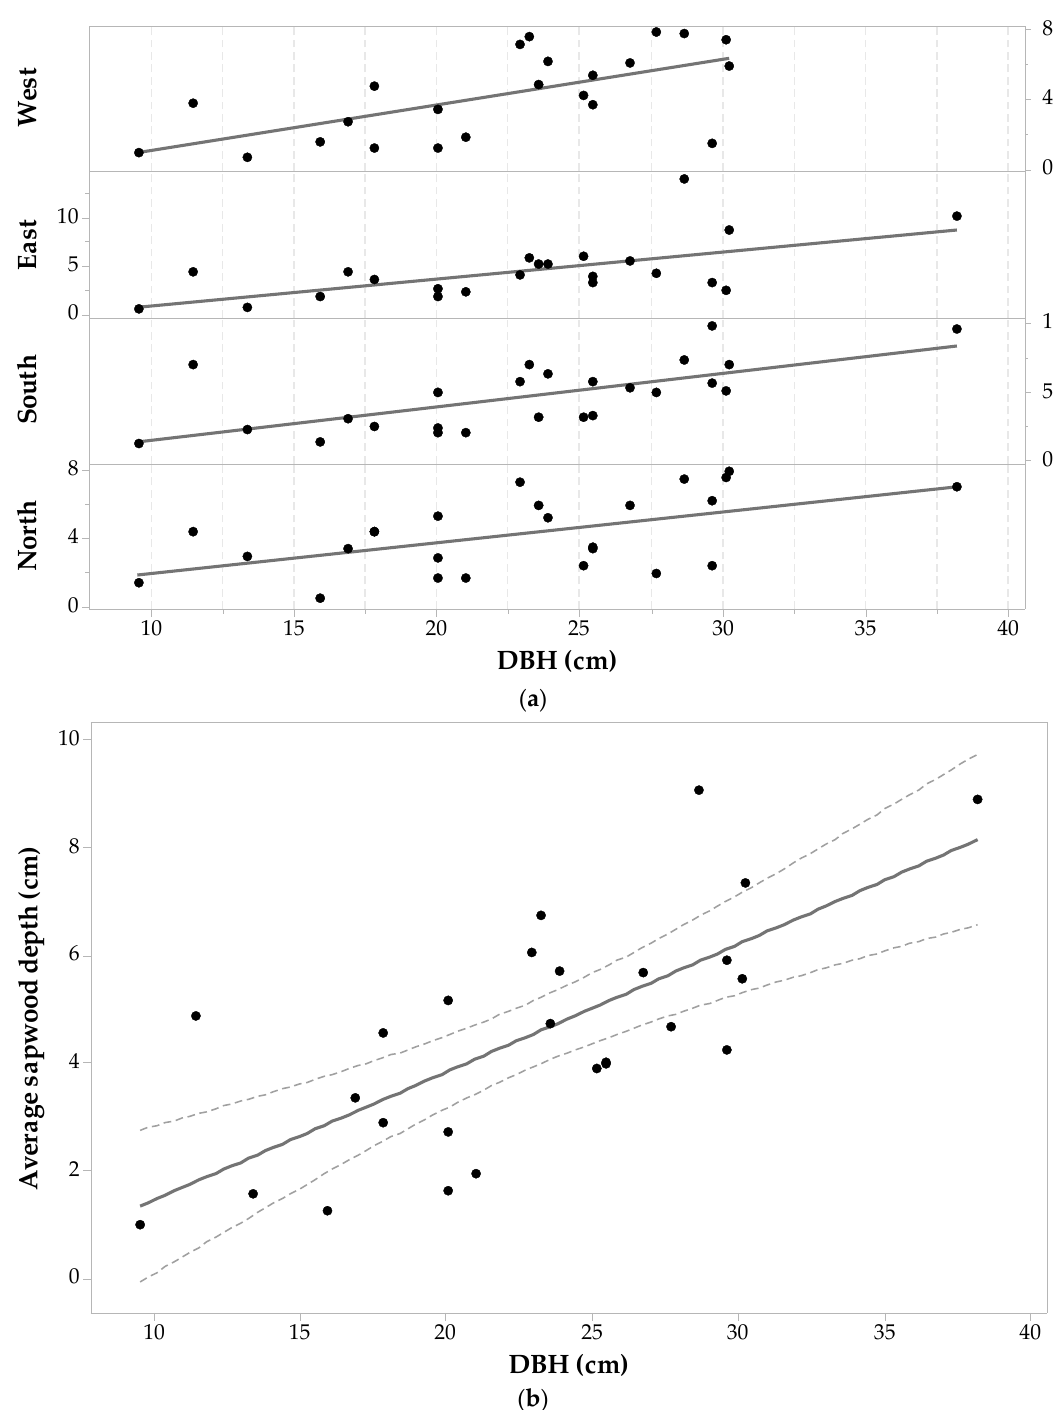
Figure 6. Populus tremuloides ( a ) sapwood depth (cm) at each cardinal point for each tree versus DBH ; and ( b ) average sapwood depth (points) with 95% confidence intervals (dashed lines) and a fitted linear regression model (solid line).